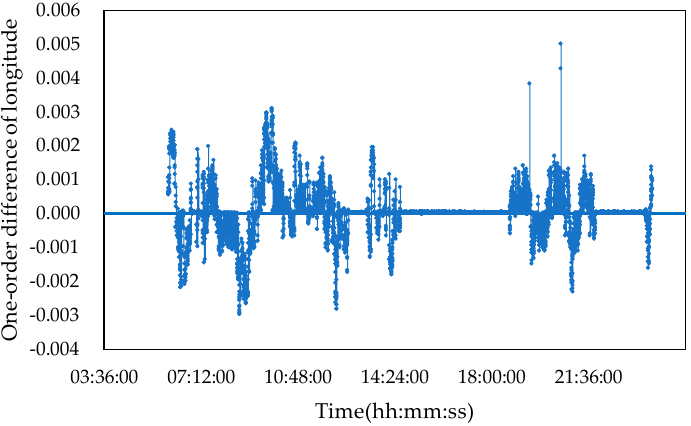
Figure 7. The time series graph of the one-order longitude difference.